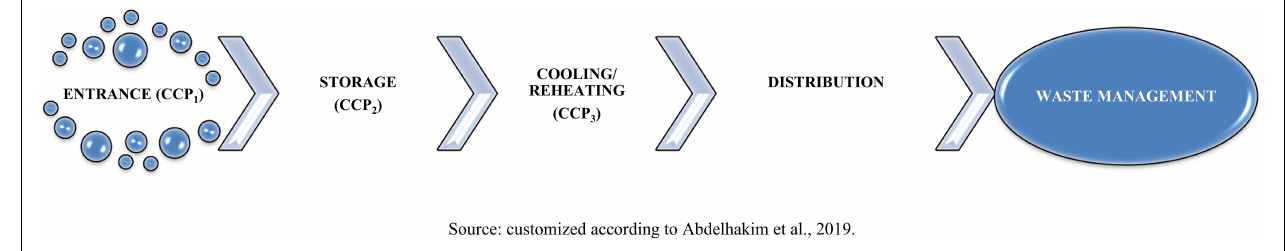
FIGURE 1 | Food handling during flights and related critical control points (CCP). Source: Customized according to Abdelhakim et al.